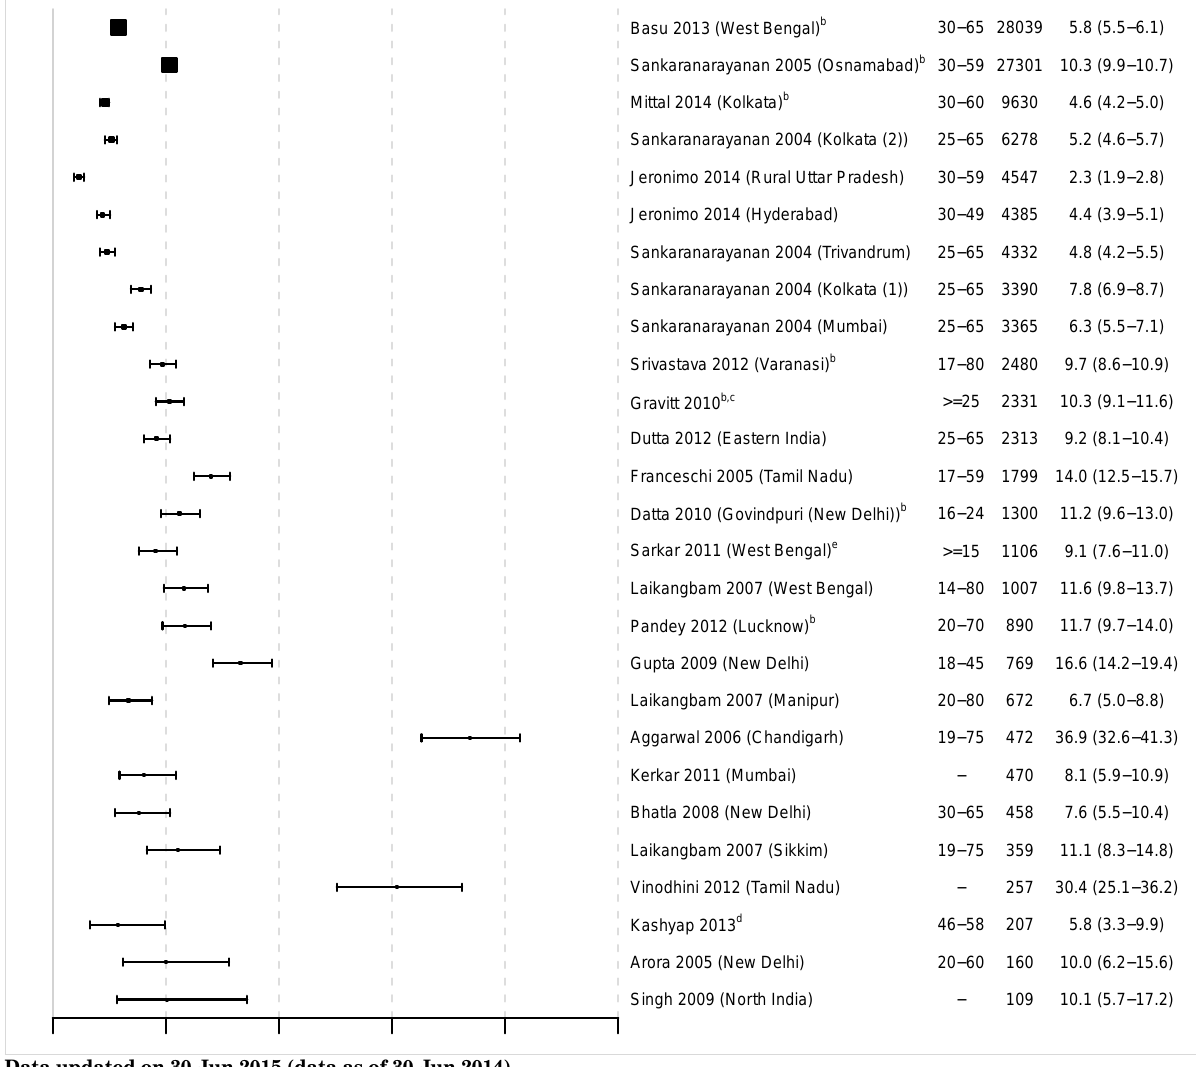
Figure 55: HPV prevalence among women with normal cervical cytology in India, by study Basu 2013 (West Bengal)